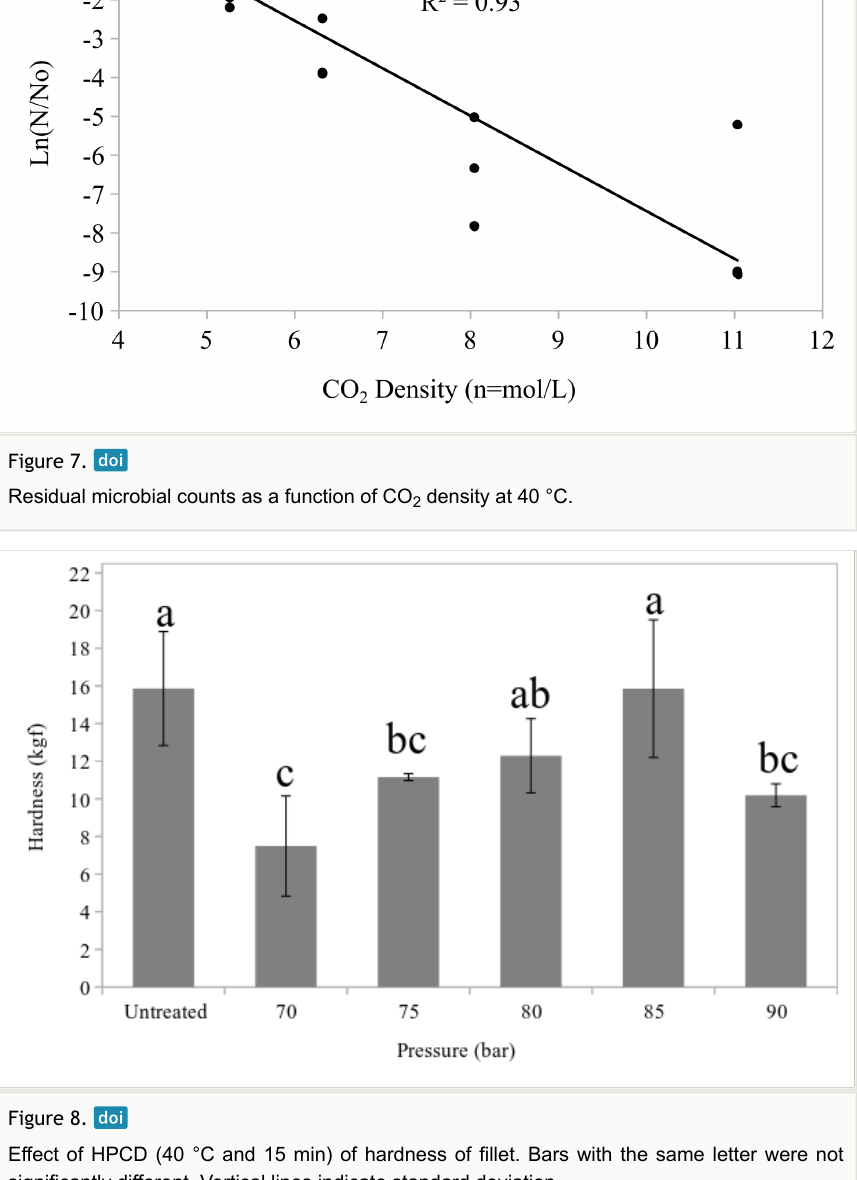
Figure 8. Effect of HPCD (40 °C and 15 min) of hardness of fillet. Bars with the same letter were not significantly different. Vertical lines indicate standard